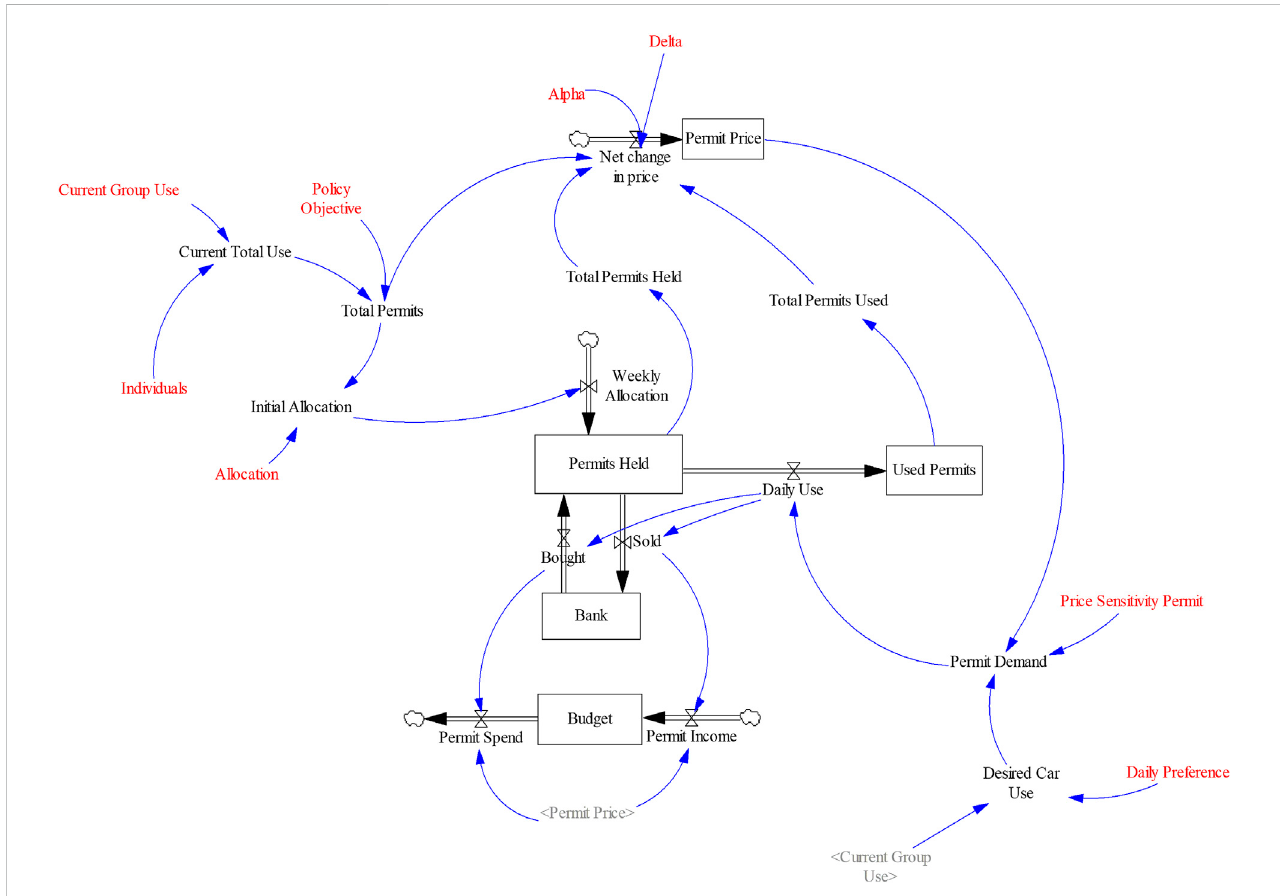
FIGURE 1 Micro-level SD Stock- fl ow model (red elements are constant inputs that are varied in sensitivity testing and scenarios).